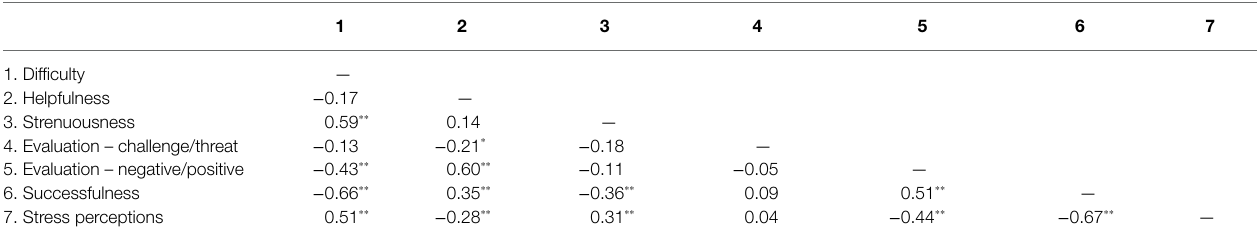
TABLE 1 | Exploratory correlations among the six manipulation check questions and participants stress perceptions ( N =